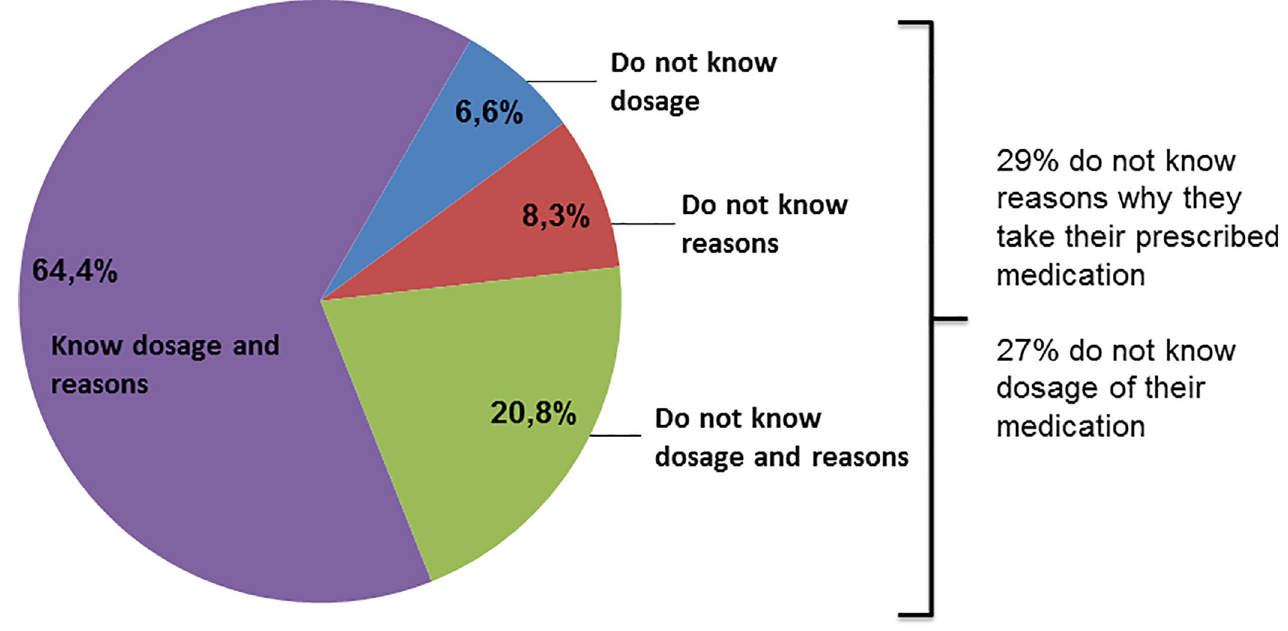
Fig 1. Knowledge about